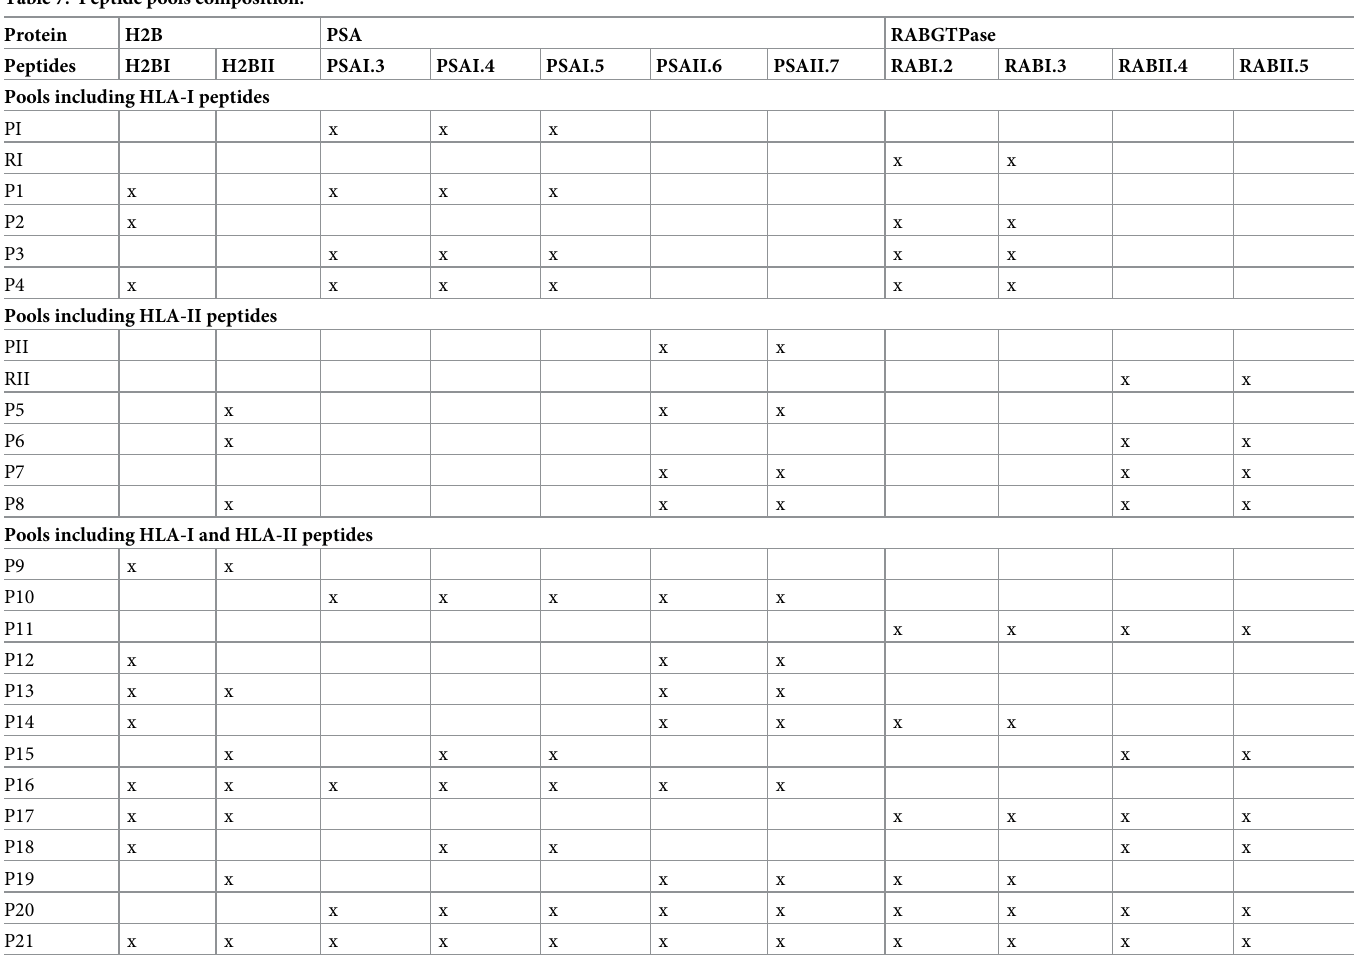
Table 7. Peptide pools composition.